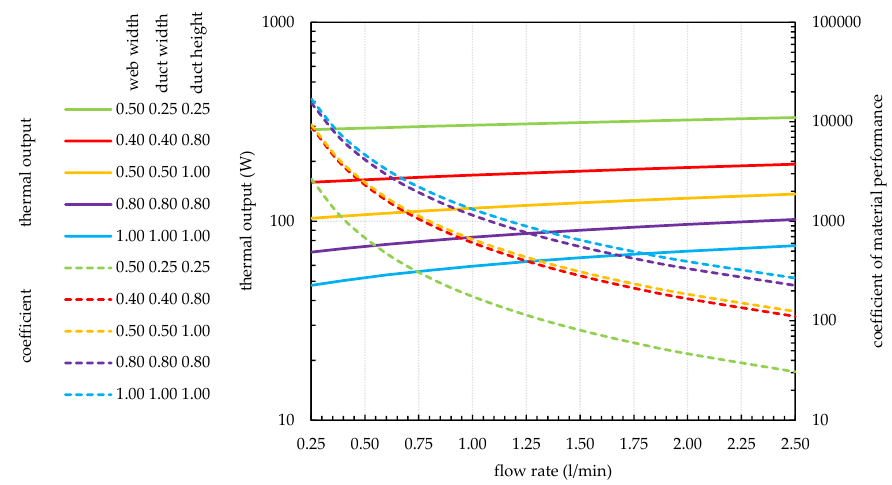
Figure 9. Calculations of thermal output and the coefficient of material performance depending on the fluid flow rate for different